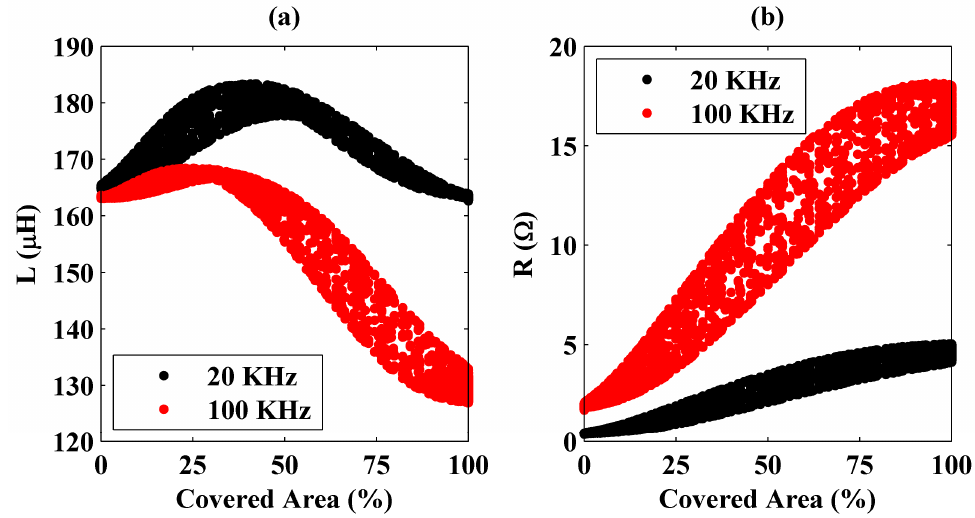
Figure 4. Variation of the measured inductance ( a ) and resistance ( b ) as a function of the coil area covered by the steel plate at 20 and 100 KHz frequencies.